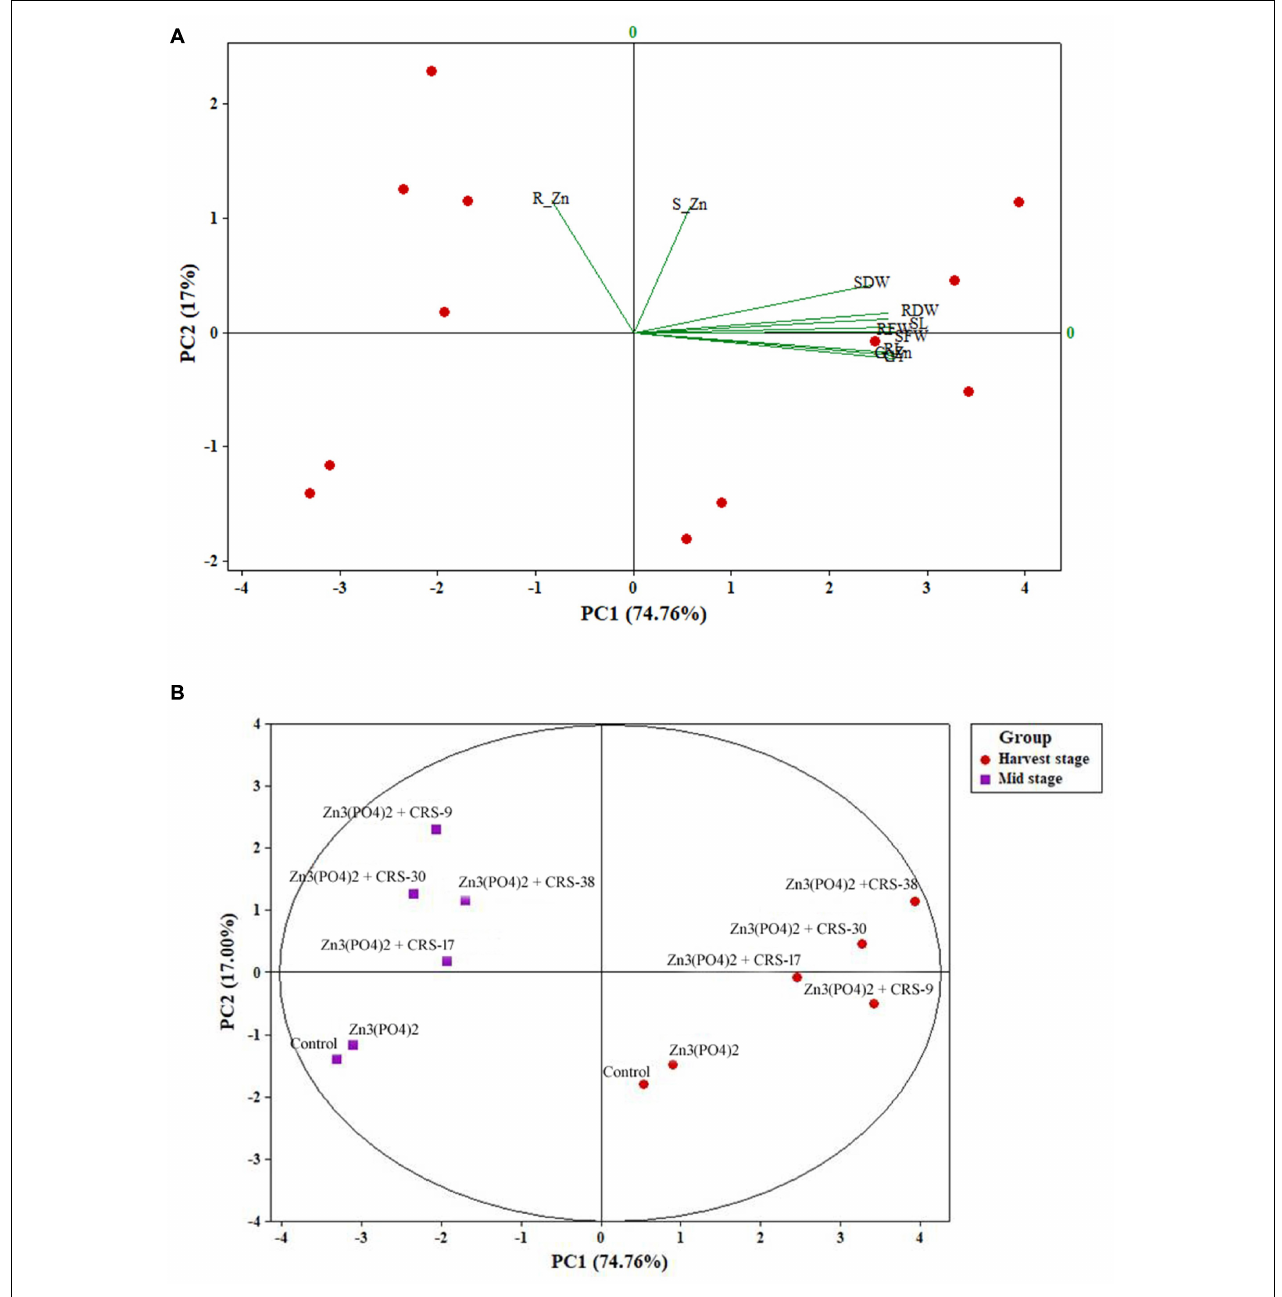
FIGURE 9 | (A) Grouping of variables of wheat crops based on principal component scores (PC1 and PC2) and (B) grouping of rhizobacterial strains based on principal component scores (PC1 and PC2) derived from variables (SWD, RWD, RL, SL, RFW, R_Zn, S_Zn, and G_Zn) of wheat crop after 30 and 120 days (harvest stage) of wheat crop